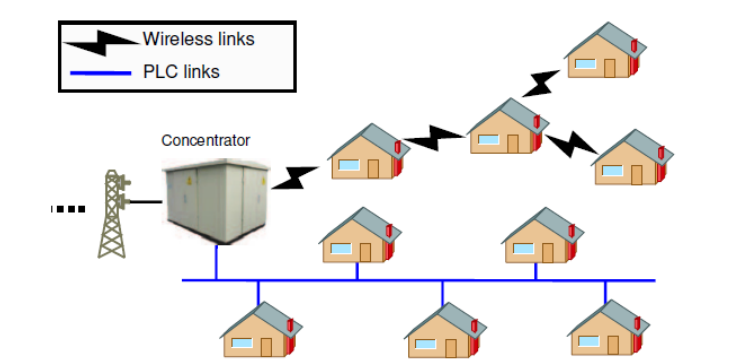
Figure 2. Smart Grid metering data